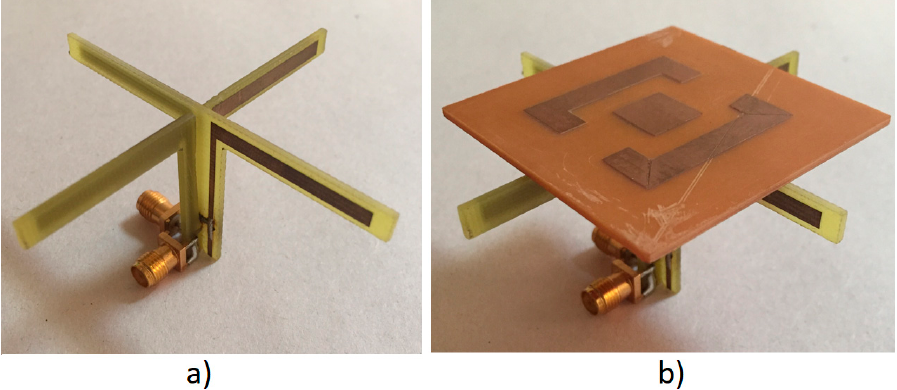
Figure 9. ( a ) Fabricated cross dipole antenna and ( b ) resonator layer integrated cross dipole antenna.